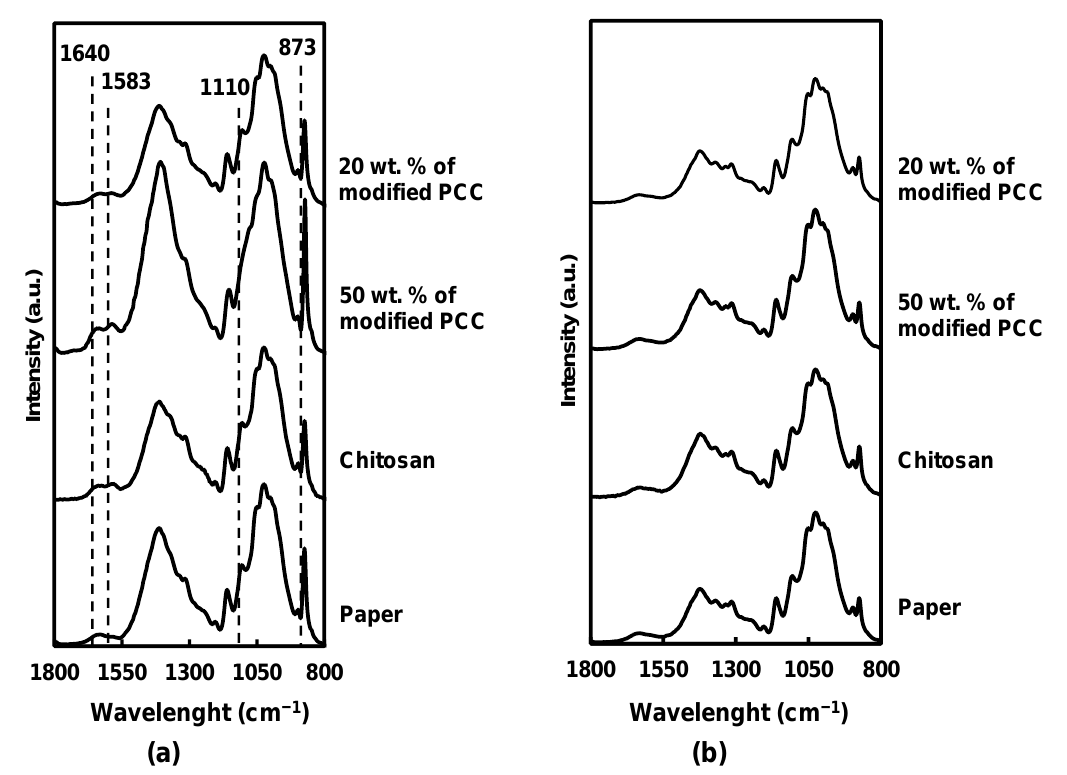
Figure 6. FTIR spectra for paper and coated paper. ( a ) Coated side, ( b ) uncoated side.